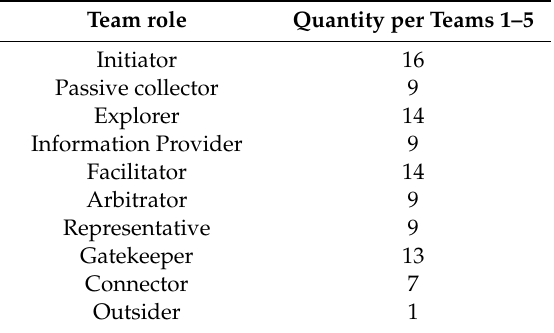
Table 2. Statistical data from Question